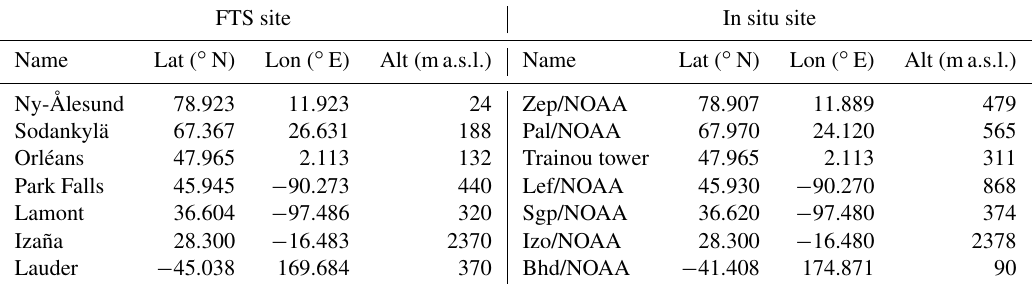
Table 3. FTS and in situ sites used for comparison to FTS tropospheric column-averaged CH 4 and surface/tower CH 4 . FTS